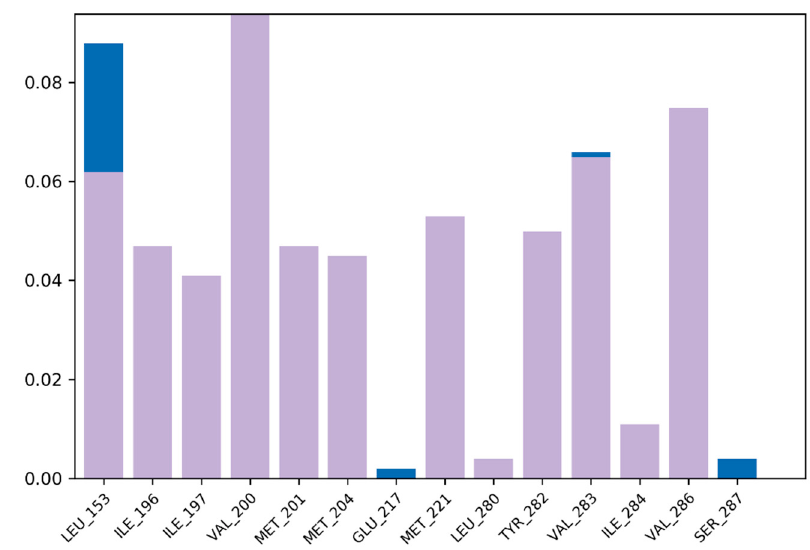
Figure 8. Topmost amino acid trajectories using standard complex .